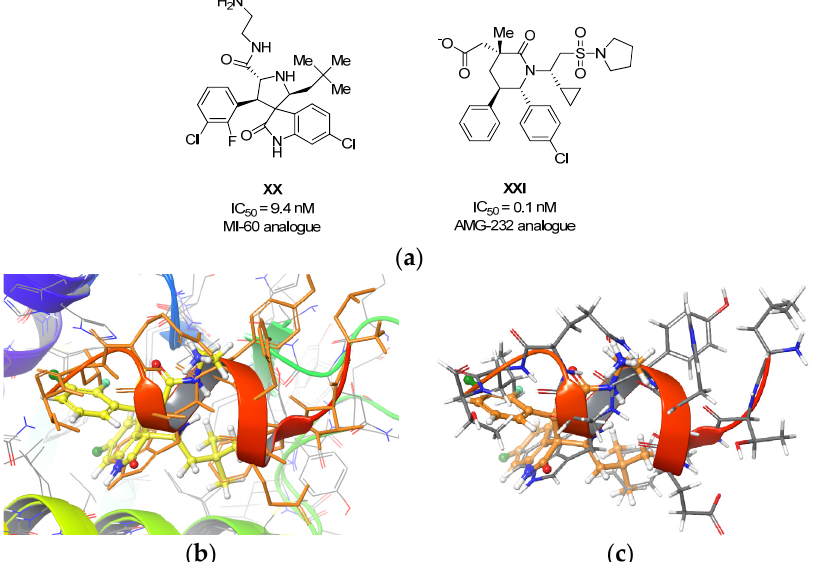
Figure 5. ( a ) Structures of the template molecules XX and XXI used for modeling; ( b , c ) the over- lapping of compound XX (yellow) with the hotspots in the domain recognition element of the p53 peptide (orange); three key hydrophobic binding points and an α -helix mimetic core.